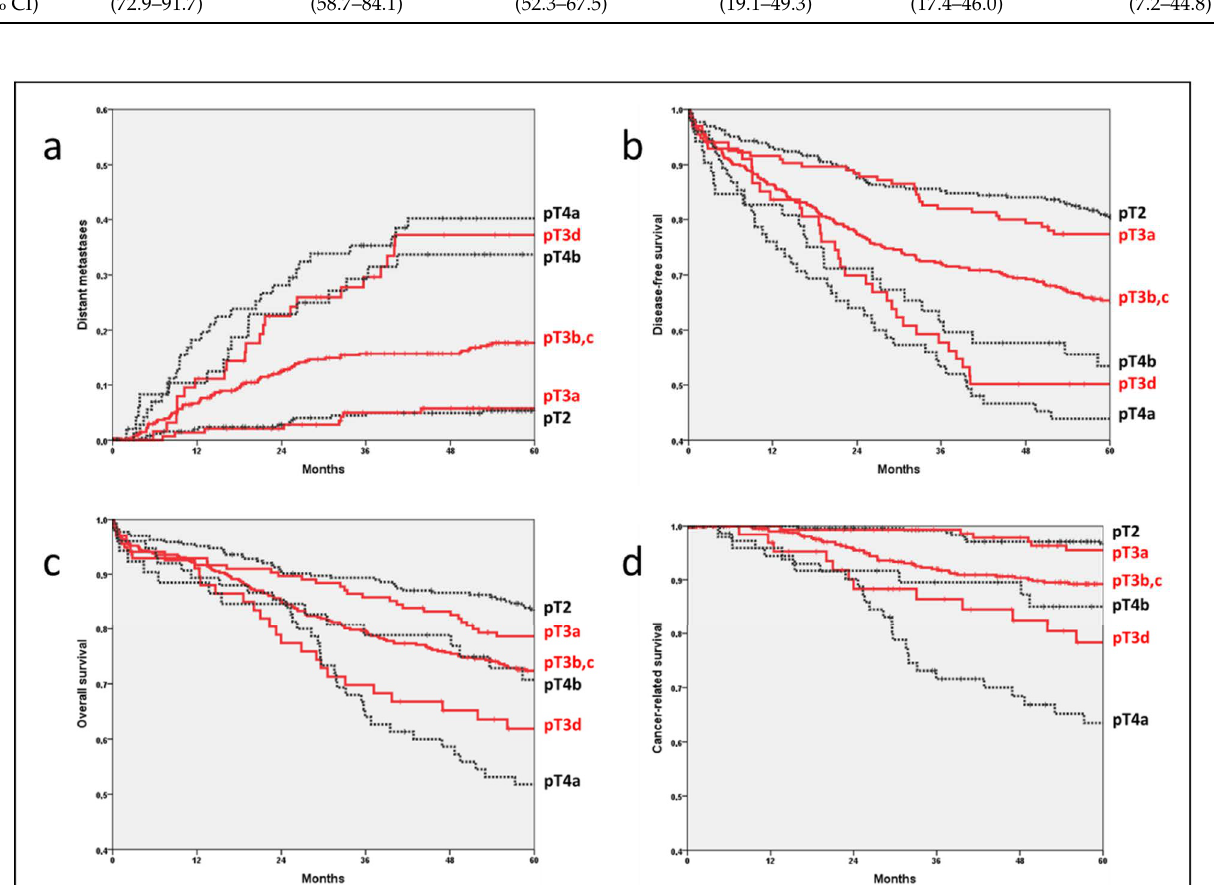
Figure 2. Comparison of the prognosis between patients with pT2 (n = 265), pT3a (n = 155) and pT3b,c (n = 433) and pT3d (n = 67), pT4a (n = 75) and pT4b (n = 52) colon carcinomas: ( a ) distant metastases, ( b ) disease-free survival, ( c ) overall survival, ( d ) cancer-related survival.